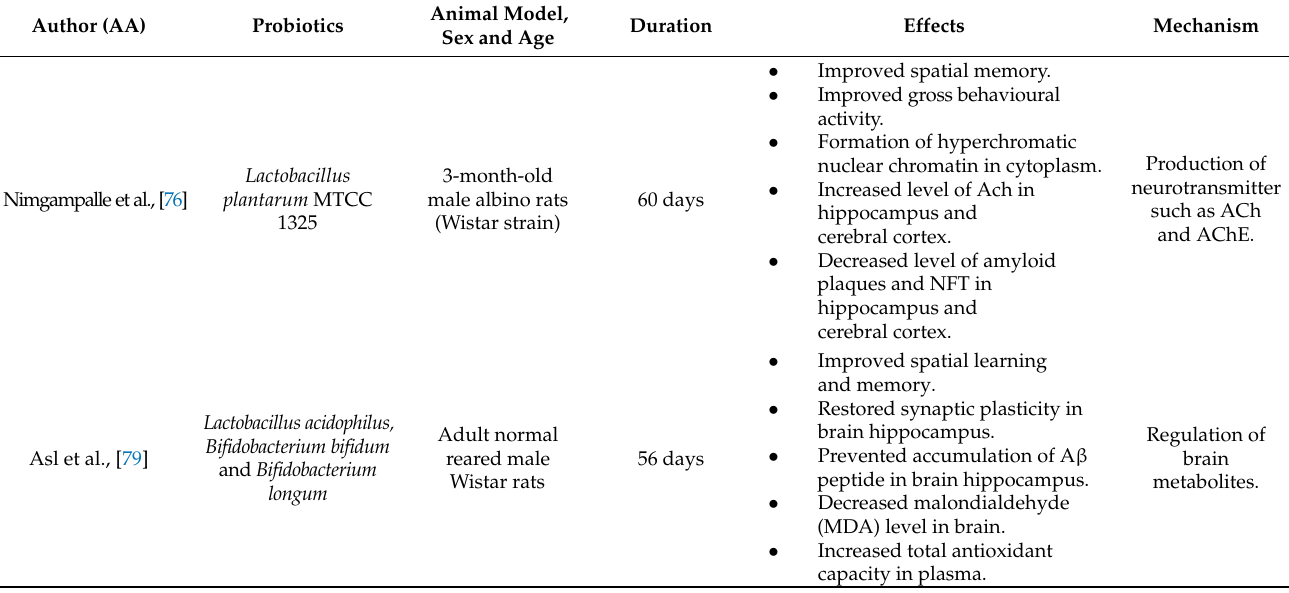
Table 1. Effects of probiotics on AD in in vivo